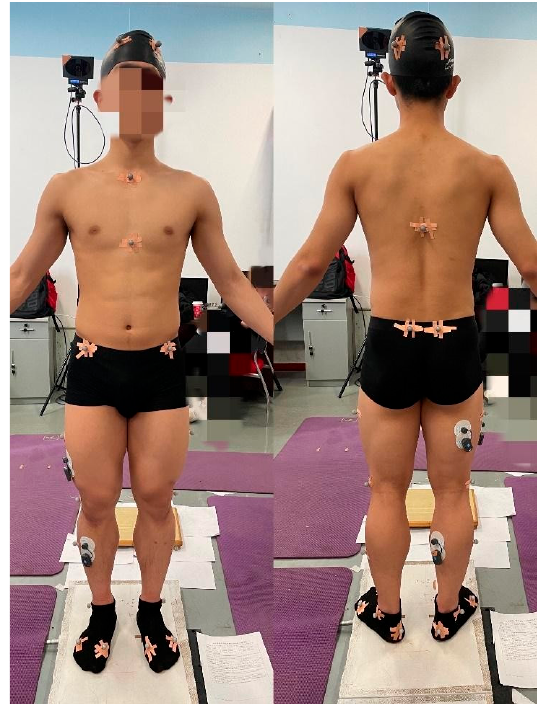
Figure 2. 25 marker points were attached to the bone marker points of the subject.